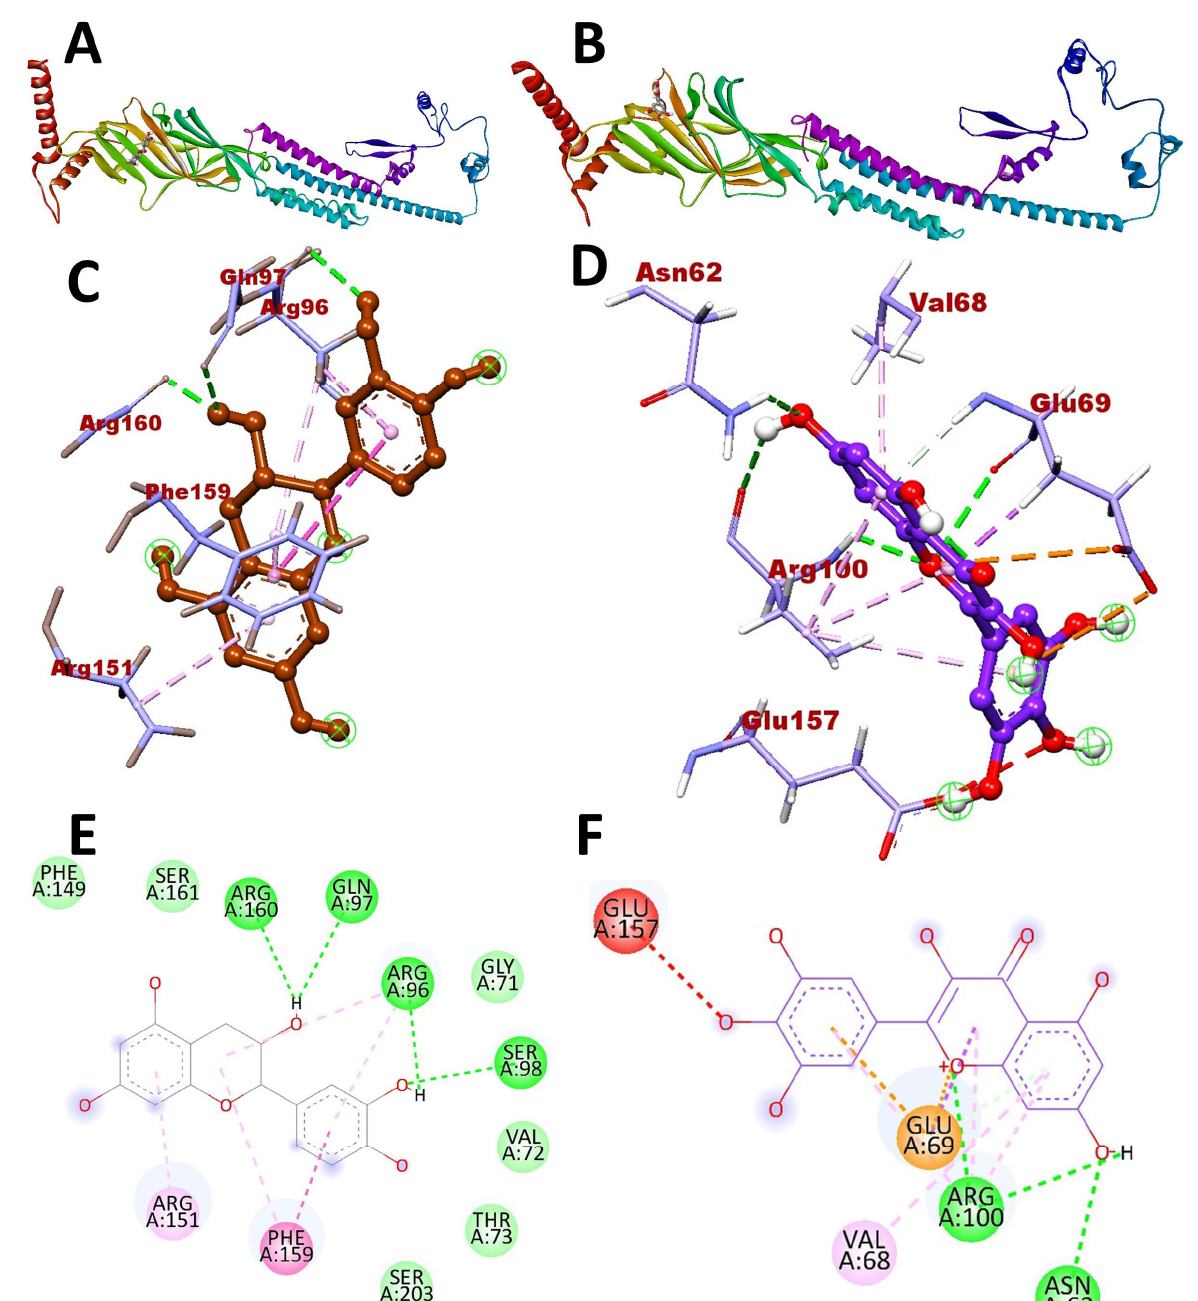
Figure 3. ( A , B ) show the complex three-dimensional structures of the RmGABACl proteins; ( C , E ) show the highly complex 3D structural interactions of the catechin and RmGABACls and their corresponding 2D interactions; and ( D , F ) show the highly complex 3D structural interactions of the myricetin and RmGABACls and their corresponding 2D